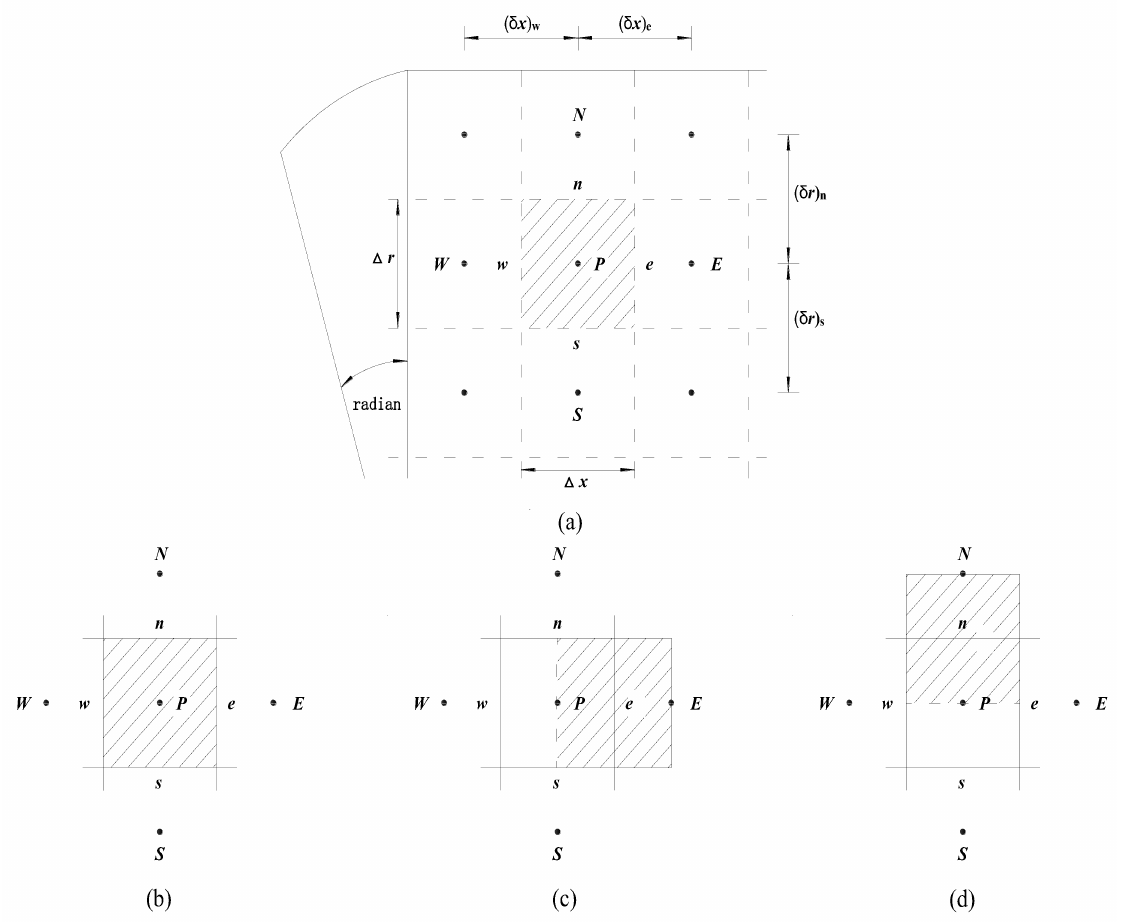
Figure 2. The staggered grid system: ( a ) the grid system in 2-D cylindrical coordinate; ( b ) main control volume; ( c ) u control volume; ( d ) v control